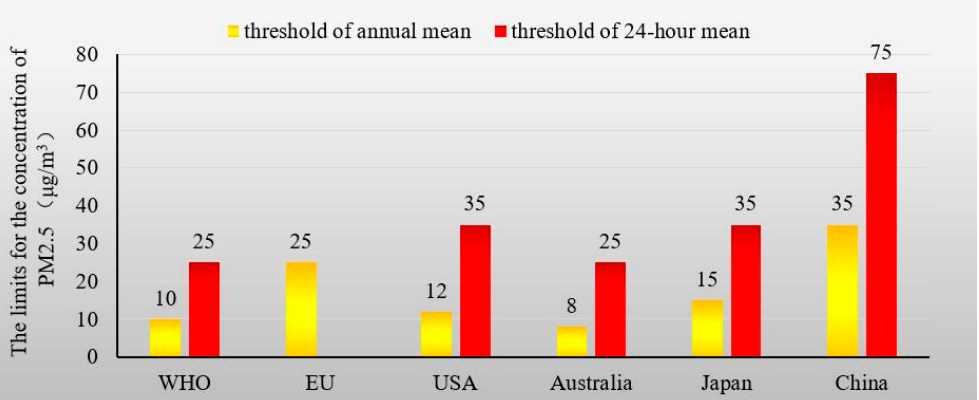
Figure 2. International limits for PM 2.5 ( µ g / m 3 ) concentrations [8]. WHO represents the World Health Organization. EU represents the European Union.